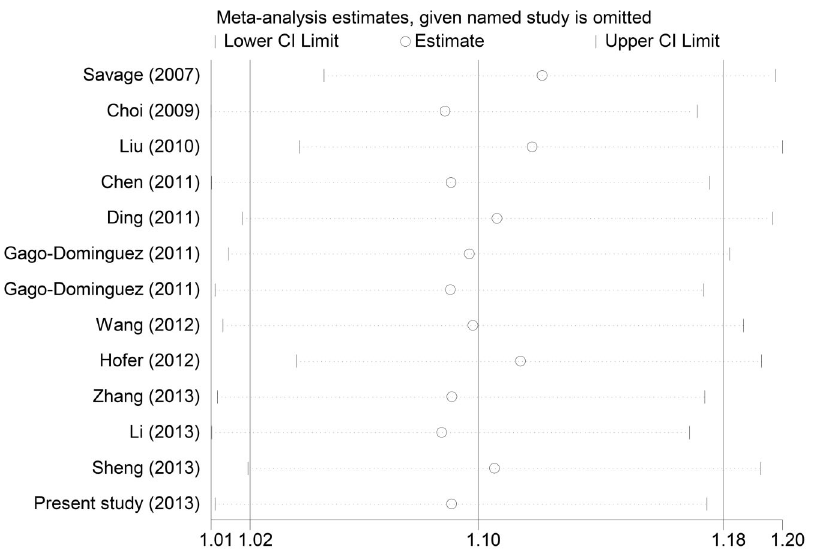
Figure 3. Sensitivity analysis of the summary OR on the association between the rs2736098 polymorphism and cancer risk under the additive model. The results were computed by omitting each study (left column) in turn. Meta-analysis random-effect estimates were used. Bars, 95% CI.